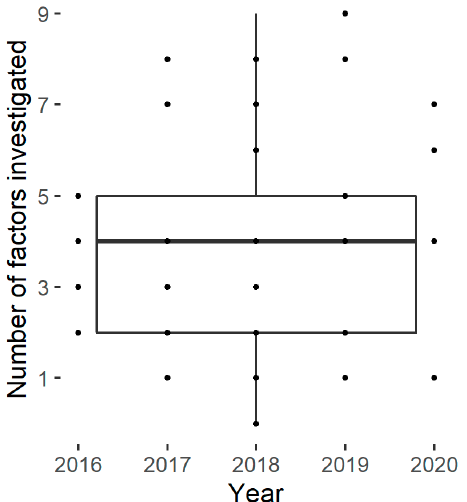
Figure 3. Number of factors studied by the selected papers.